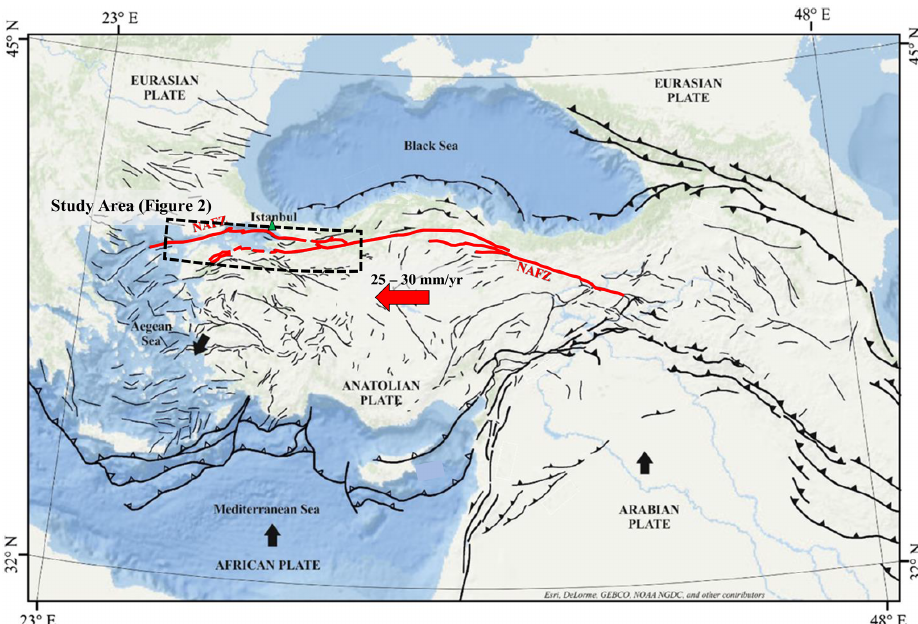
Figure 1. Regional tectonic setting. Modified from Duman et al. (2018). The active faults are in black except for the North Anatolian Fault Zone (NAFZ) which is in red. The black and red arrows show the plate motion relative to a fixed Eurasia. The dotted box indicates the study area detailed in Fig. 2.